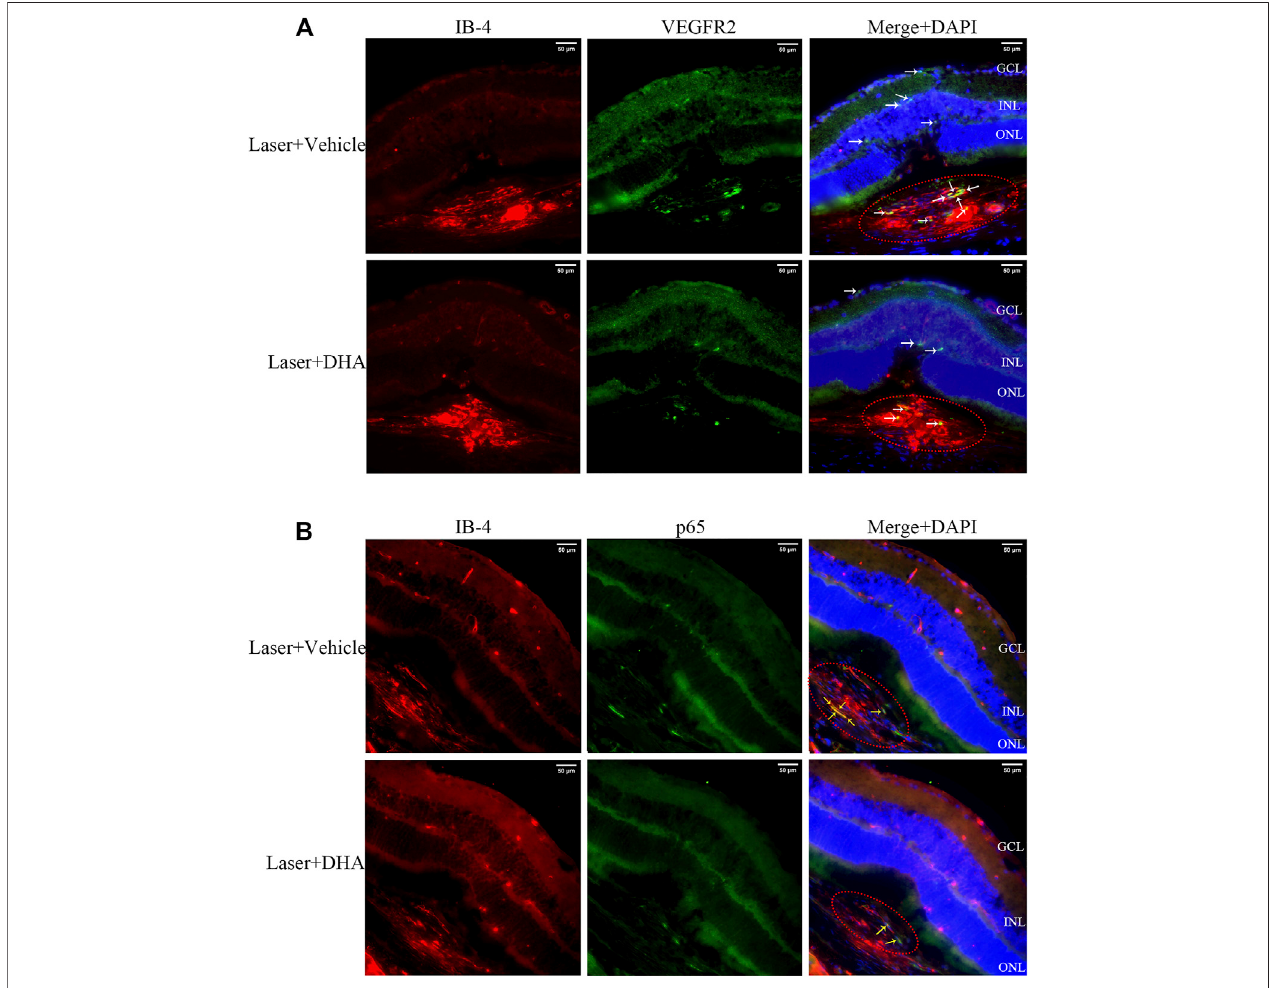
FIGURE4| VEGFR2andNF- κ Bp65expressionatthesiteofchoroidalneovascularization(CNV)lesionsanalyzedbyimmunostainingimages.TheCNVlesionwas indicatedbytheredellipse. (A) Thesectionswere fl uorescentlylabeledwithVEGFR2antibody(green)andisolectinB4(red).VEGFR2hadalittlepositivestaininginretinal capillary endothelial cells in both the vehicle and dihydroartemisinin (DHA) groups. However, in CNV formation spots, the positive staining area of VEGFR2 in the DHA group was smaller than that in the vehicle group (white arrow). (B) The sections were fl uorescently labeled with NF- κ B p65 antibody (green) and isolectin B4 (red). The positive staining area of NF- κ B p65 in the DHA group was signi fi cantly reduced compared to that in the vehicle group, which was mainly seen in CNV areas (yellow arrow). GCL, Ganglion Cell Layer; INL, Inner Nuclear Layer; ONL, Outer Nuclear Layer. Scale bar, 50 μ m.